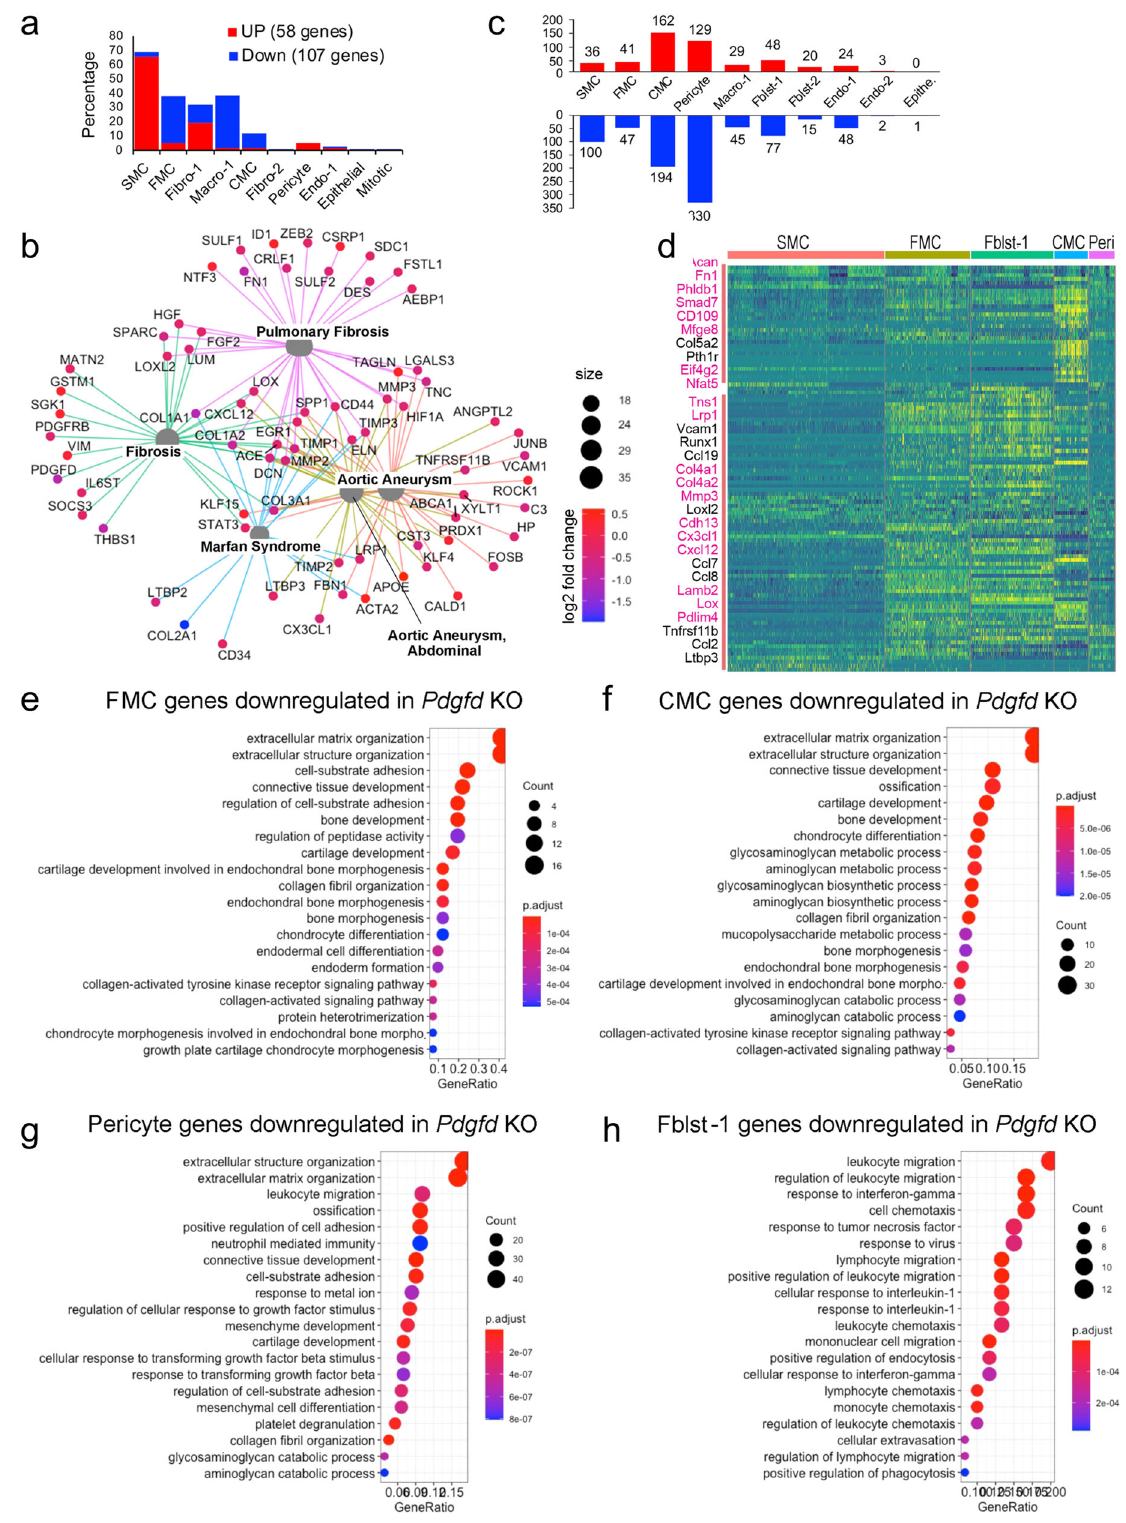
Fig.4|LossofPdgfdmitigatesthesmoothmusclecellchondrogenictransition and in fl ammatory pathway activation. a Bar plot showing the number of upre- gulatedgenes(58,redbars)anddownregulatedgenes(107,bluebars)derivedfrom all KO compared to all Ctl disease tissues. b Gene-disease network analysis of the differentially expressed genes (DEGs) among lineage traced cells in KO compared with Ctl as determined by gene set enrichment analysis with clusterpro fi ler , and shown as a gene-gene regulatory network with enrichplot . c Bar plot displaying numbers of DEGs in individual clusters, for KO compared with Ctl. d Heatmap